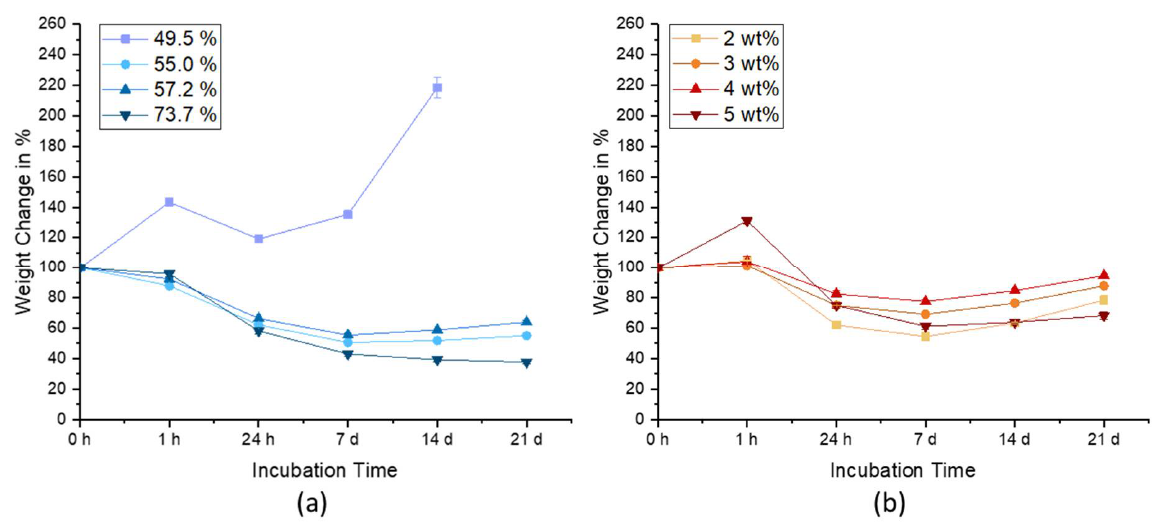
Figure 4. Behavior of hydrogels after storage in 1 mL PBS: ( a ) Various batches with DO 49.5%, 55.0%, 57.2%, and 73.7% with a content of 3 wt%; ( b ) blend (DO 53.3%) with various contents.